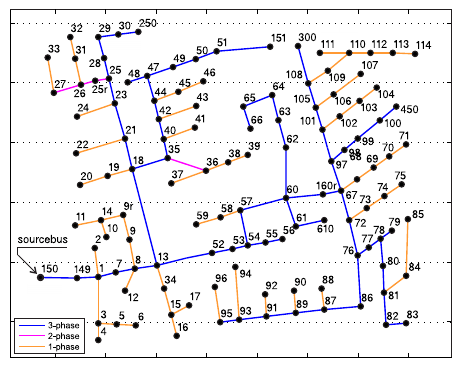
Figure 12. The 123-bus grid.